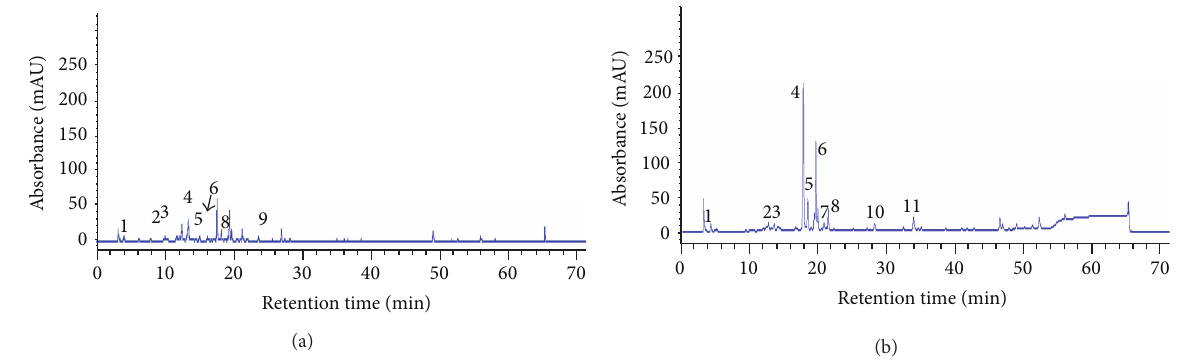
Figure 1: HPLC profile of phenols from leaves extract of Gossypium hirsutum treated with methyl jasmonate (MeJA). Detection is shown at 284 nm. Peaks were identified by comparison with reference standards when available or by HNMR data (retention time). (1) Gossypol (4.237 min); (2) caffeoyl-D-glucose (12.770 min); (3) catechin (13.597 min); (4) 3- p -coumaroylquinic acid (17.895min); (5) ferulic acid (18.524 min); (6) gossypetin (19.704); (7) chlorogenic acid (20.995 min); (8) piceatannol (21.545 min); (9) trans -resveratrol (26.993 min); (10) pterostilbene (28.344 min); (11) cichoric acid (34.083 min). (a) No-MeJA treated plants. (b) Plants treated with MeJA 5.0 mM.